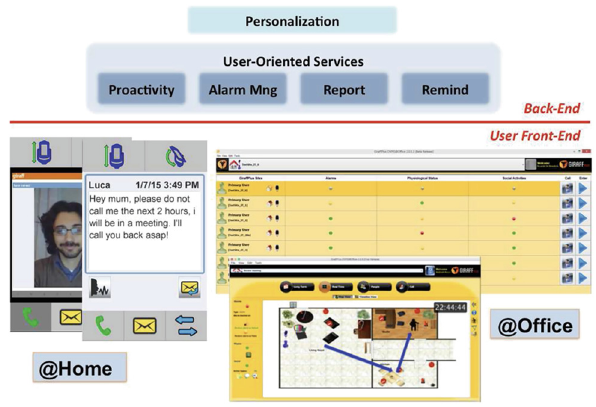
Figure 6: Personalized services for primary and secondary